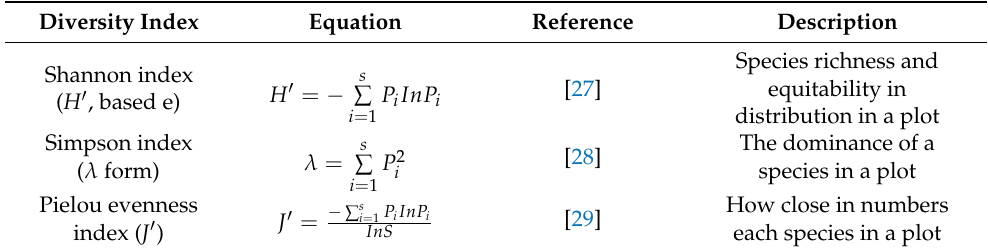
Table 1. Three diversity indexes and corresponding equations were used in the study. Note: S is the total number of tree species in a plot; P i is the proportional abundance of species i relative to the total abundance of all species S in a plot; InP i is the natural logarithm of this proportion.